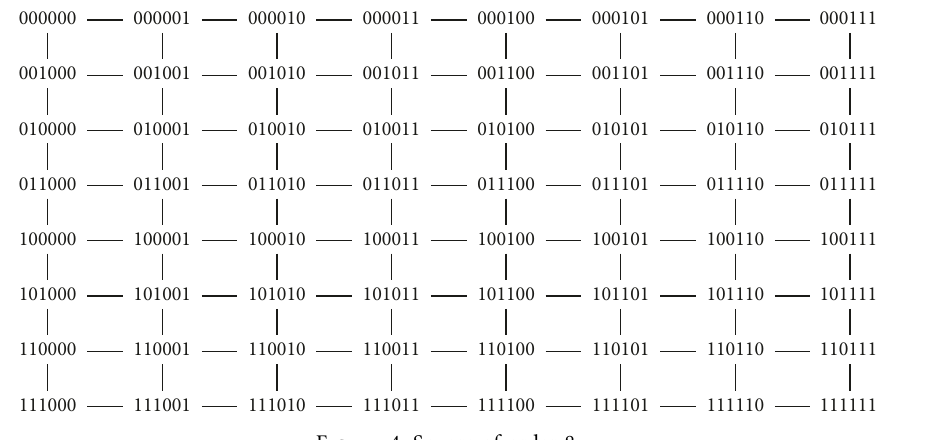
Figure 4: Square of order